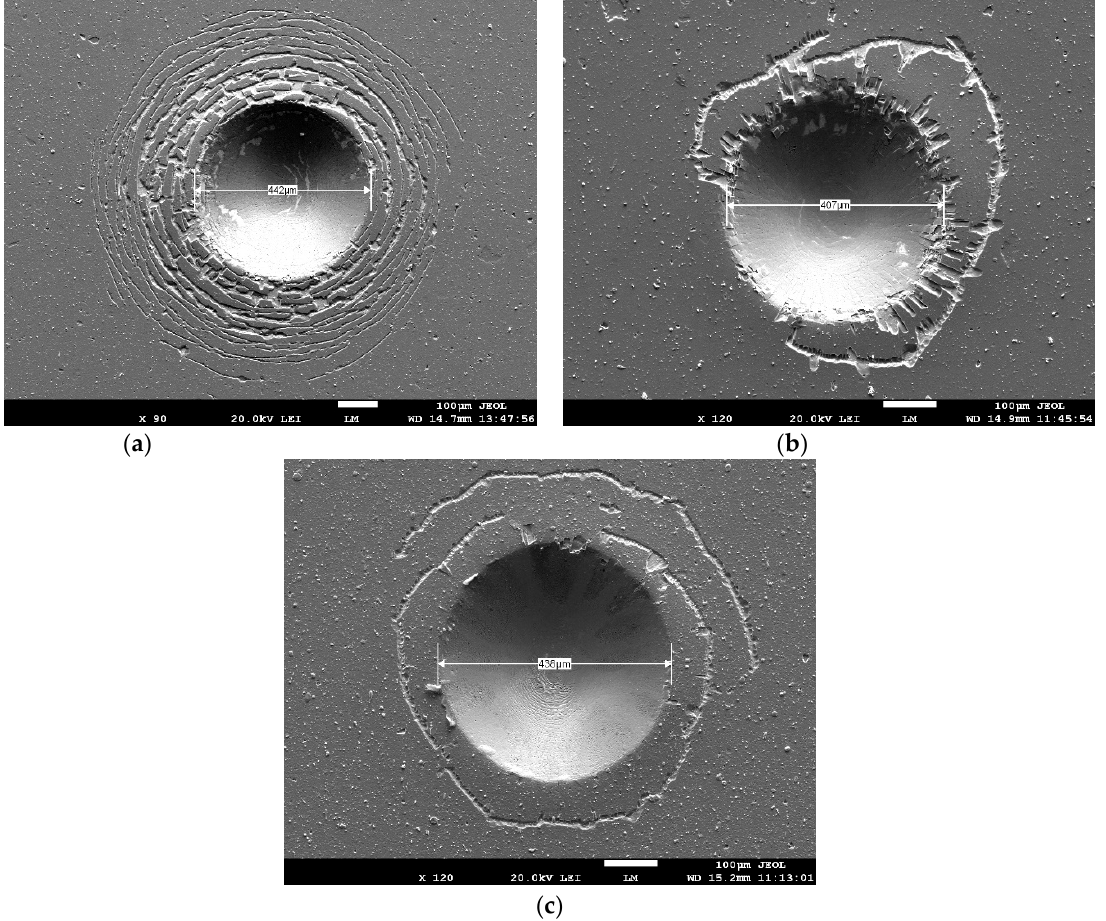
Figure 11. Indentation imprints at F max = 1500 N: ( a ) TiXCo 3 /HSS, ( b ) nACo 3 /HSS, and ( c ) nACo 3 /SC.